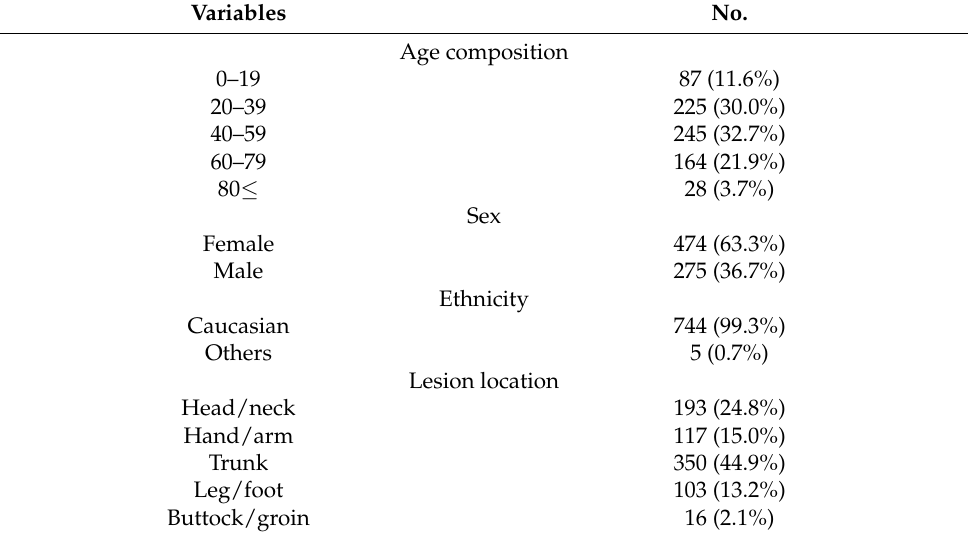
Table 2. Characteristics of the included